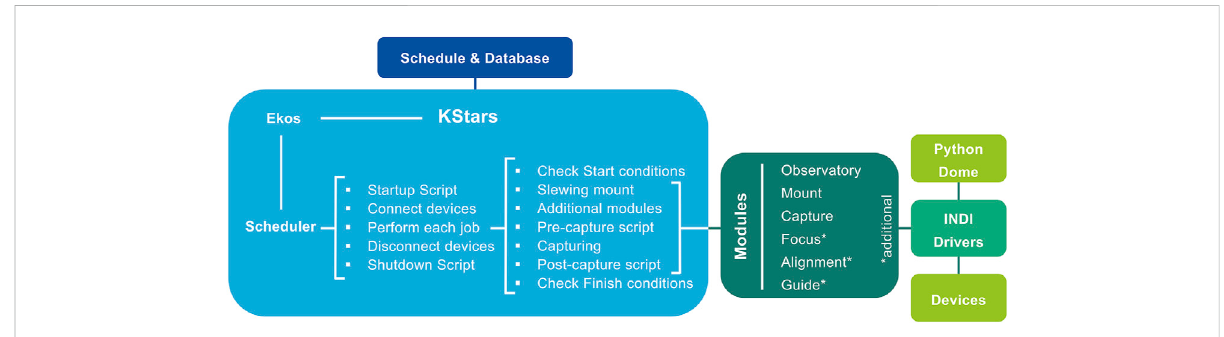
FIGURE 5 Observation Pipeline illustrated with its work fl ow. It stars with the Schedule and Database created by the Pre-Observation Pipeline in Figure 4 and starts the observation in the Ekos Scheduler. All operations from switching on the components through the capturing process to the end of the observation are executed automatically by the Scheduler functions. Here, customized scripts were embedded in the designated places at Startup, Shutdown and before and after each Capture respectively. When executing the jobs, the scheduler activates the corresponding Ekos modules, which in turn controls the devices via the INDI